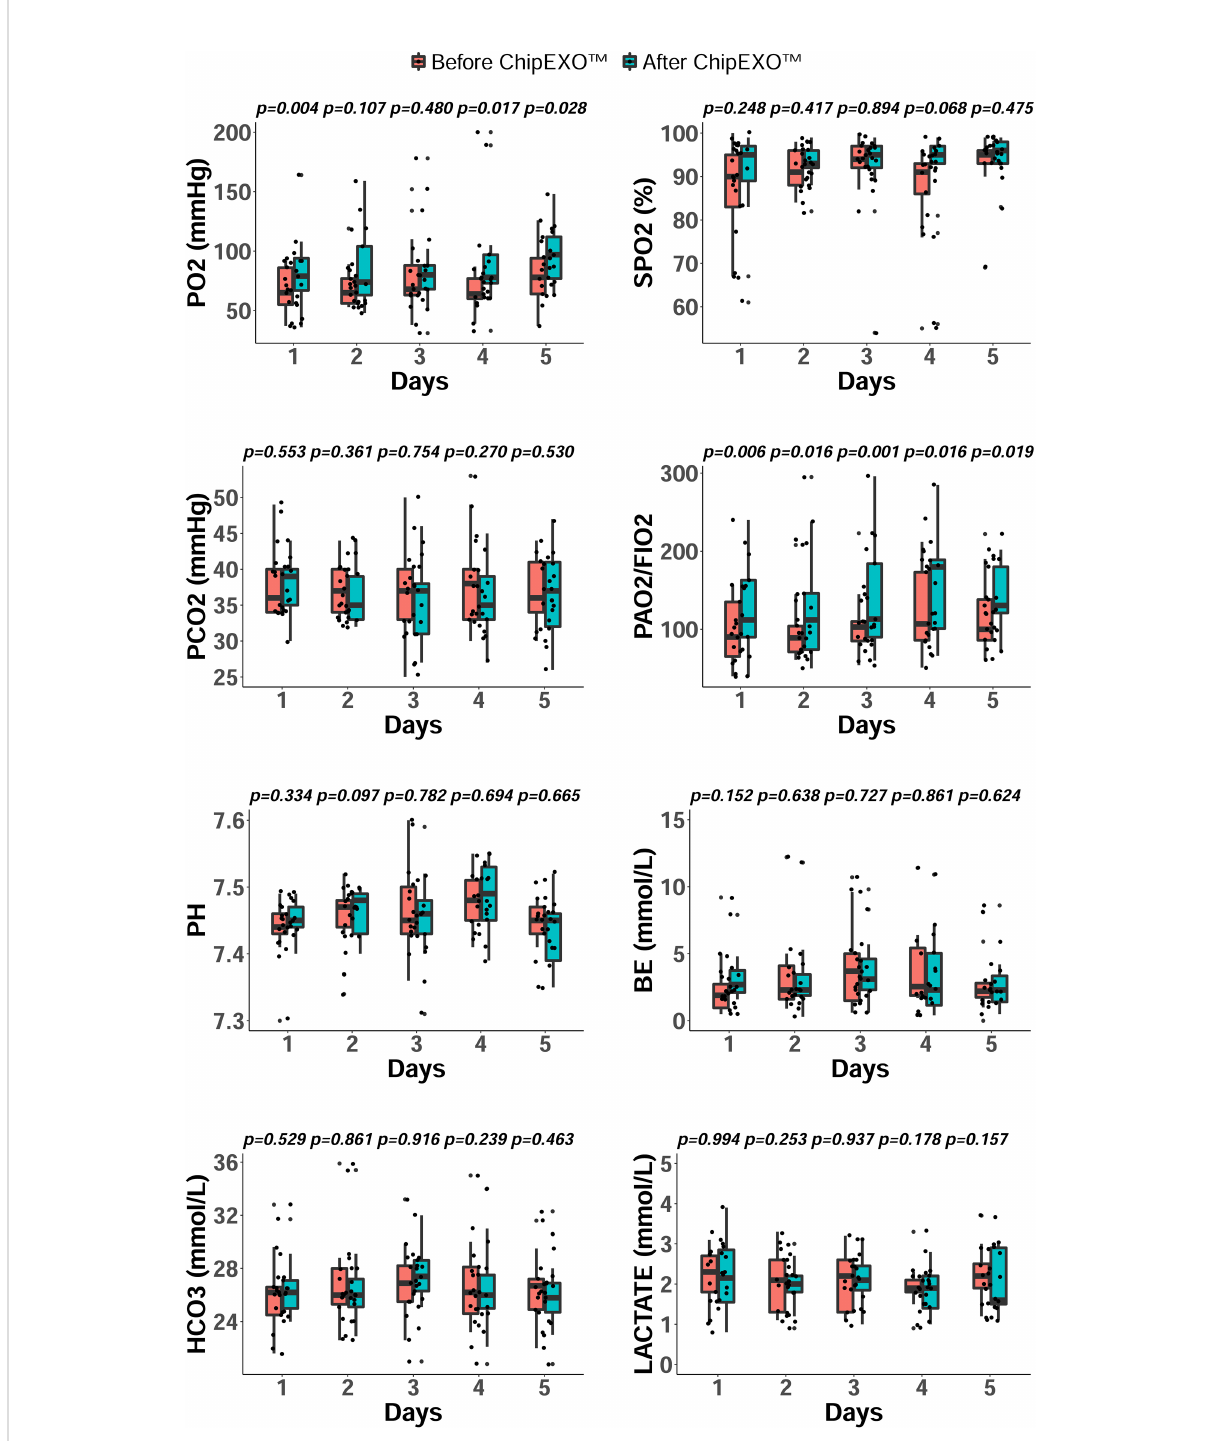
FIGURE 2 Arterial Blood Gas parameters during ChipEXO TM Treatment. The respiratory parameters of oxygenation and ventilation were followed daily before (red) and two hours post (green) ChipEXO TM treatment for 5 days. Results are shown as grouped and scattered boxplots for the distribution and change in each of the parameter studied. P values, by Wilcoxon test, display the levels of signi fi cance between pre- and post- treatment at a given time point. Abbreviations (normal range): pO 2 , partial pressure of oxygen (83-108 mmHg); pCO 2 , partial pressure of carbon dioxide (35-45 mmHg); sPO 2 , oxygen saturation (95%-99%); BE, base excess (-3 to 3 mmol/L); HCO3, bicarbonate (22-28 mmol/L); pH (7.35- 7.45), lactate (0.5-1.5